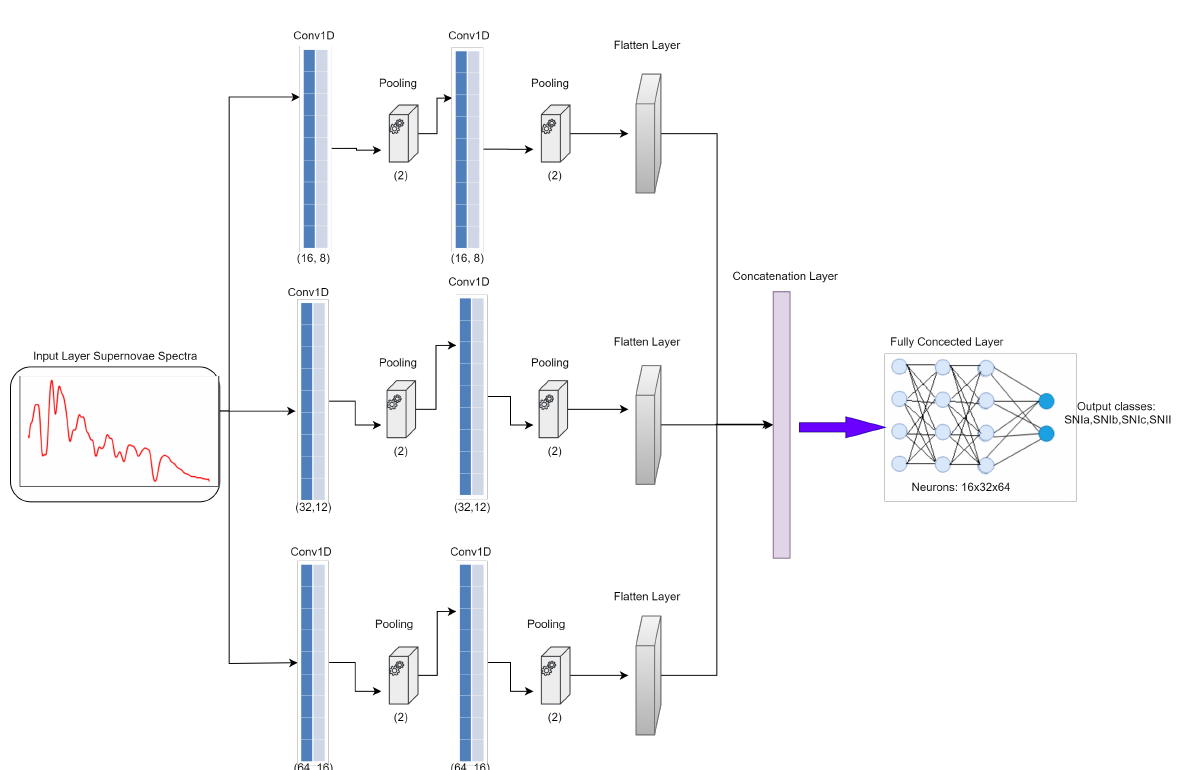
Figure 7. DANI’s Multiple Window Convolutional Neural Network to spectral